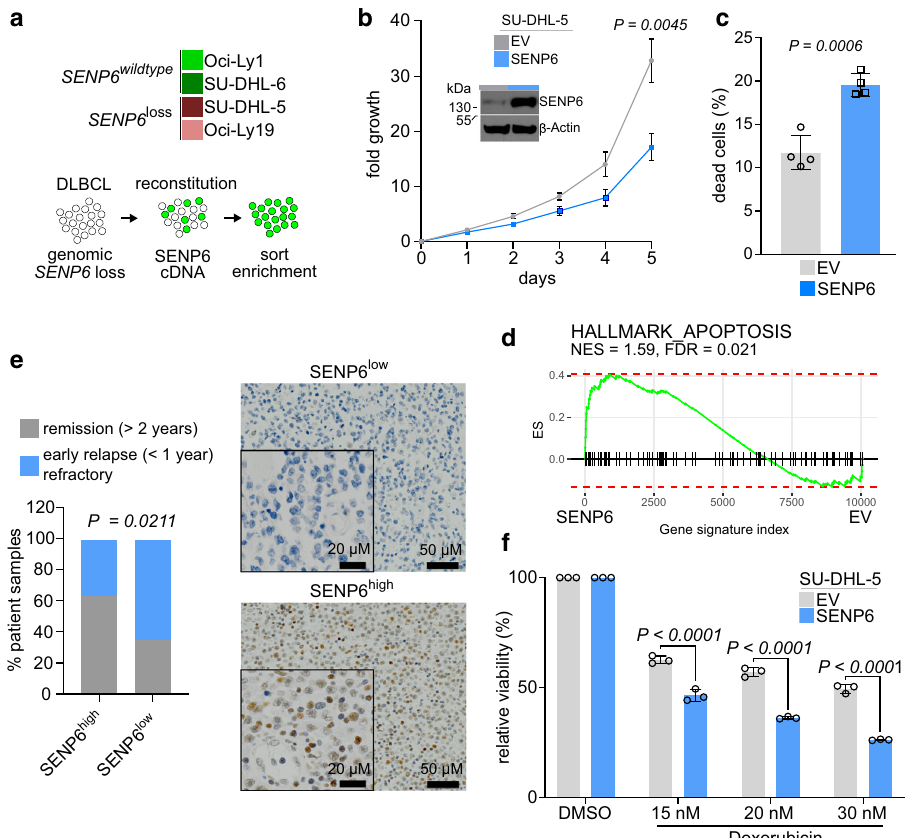
Fig. 3 Low SENP6 expression is associated with aggressive tumor biology. a Results of SENP6 copy number analysis of human DLBCL cell lines derived from cancer cell line encyclopedia (top) and experimental work fl ow for SENP6 reconstitution (bottom). b Analysis of SENP6 protein expression and cell proliferation upon SENP6 reconstitution versus empty vector (EV) transduced control cells ( n = 3 independent experiments). Data are presented